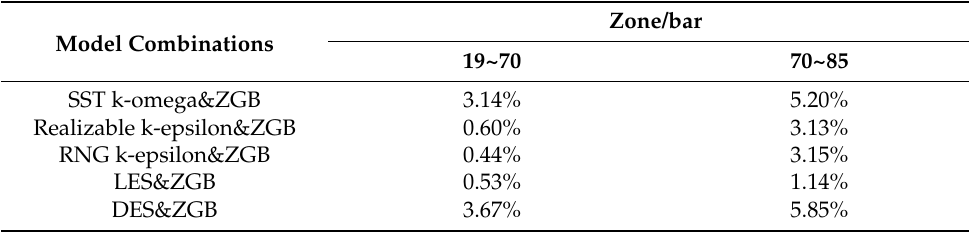
Table 4. Comparison of the error of the simulated average value of outlet mass flow rate for each model combination with the experimental data.